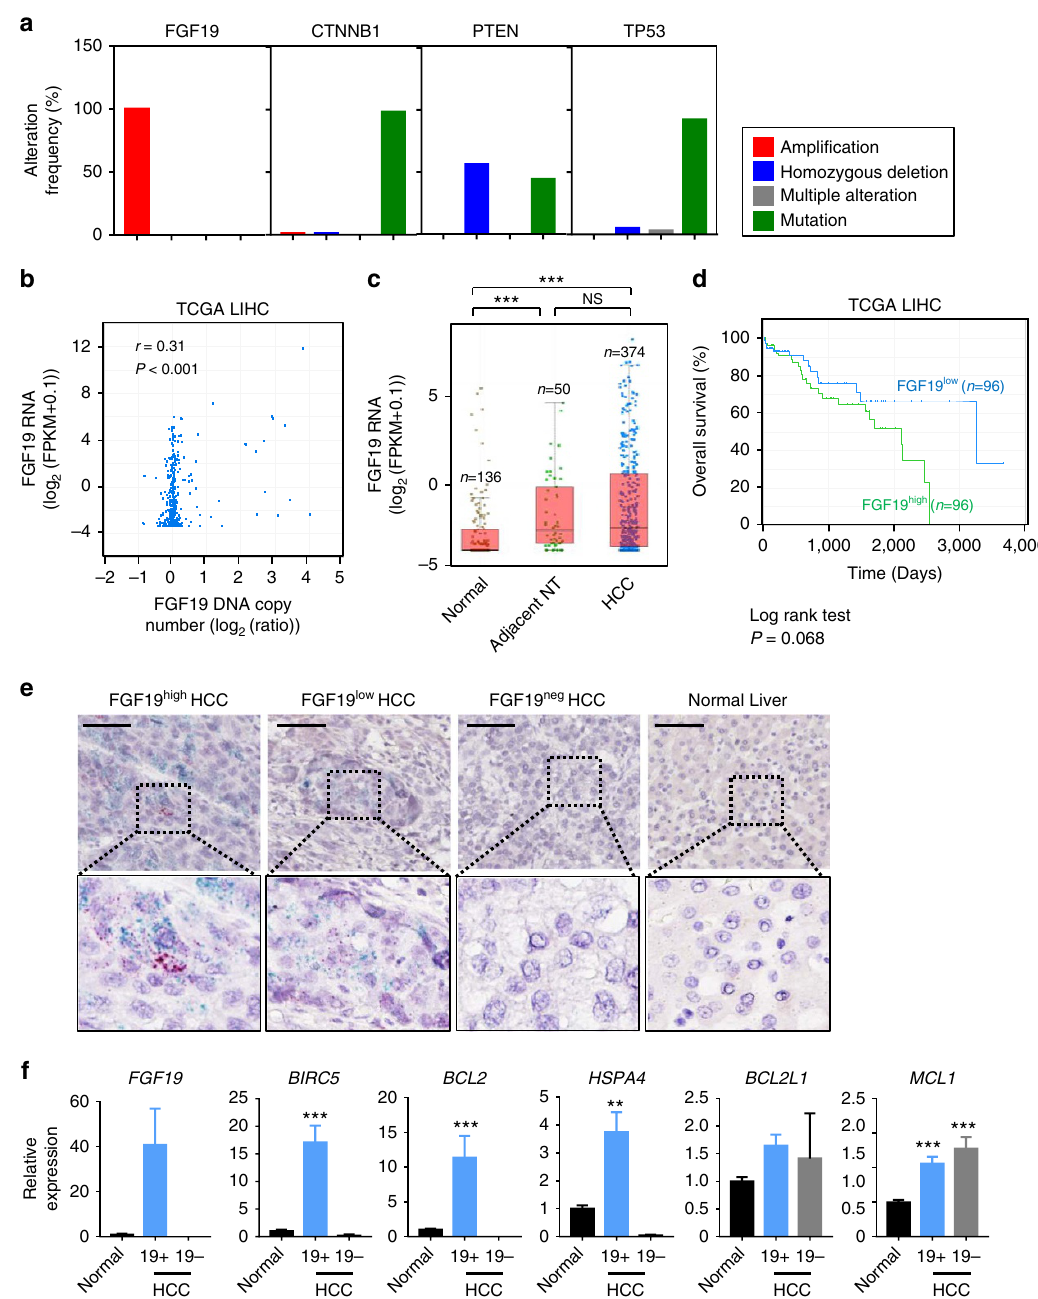
Figure 8 | Overexpression of FGF19 and STAT3 target genes in human HCCs. ( a ) Frequency of FGF19 genetic alterations in human HCCs from the